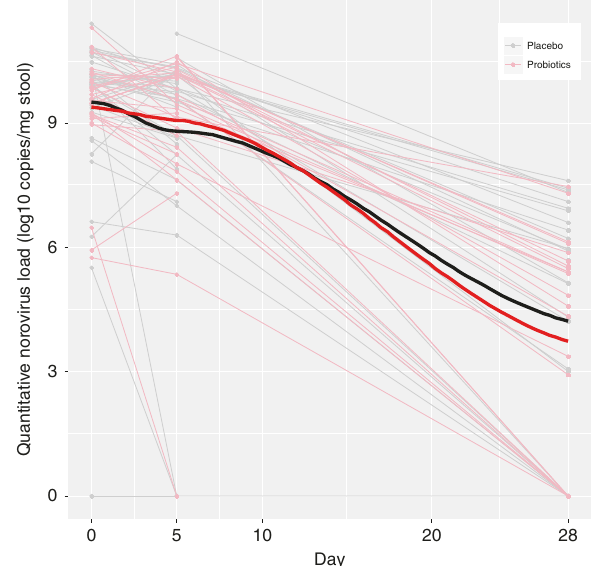
Fig. 3 Change in adenovirus viral load quantity in stool over time, compared between probiotic and placebo groups. Stool Log10 transformed copies of adenovirus by treatment group [probiotic ( N = 25) vs. placebo ( N = 20)] across time (in days) following randomization on the x -axis. Thin light gray lines refer to patients provided placebo, this red lines refer to those provided probiotic; thick black and red lines to locally weighted smoothing lines respectively. The two-sided P -value represents the result of a linear mixed effect model with random intercepts (subjects random effect) comparing placebo (reference group) vs. probiotic on viral load including time and treatment group variables, and an interaction term for the latter two. Source data are provided as a Source Data fi le.